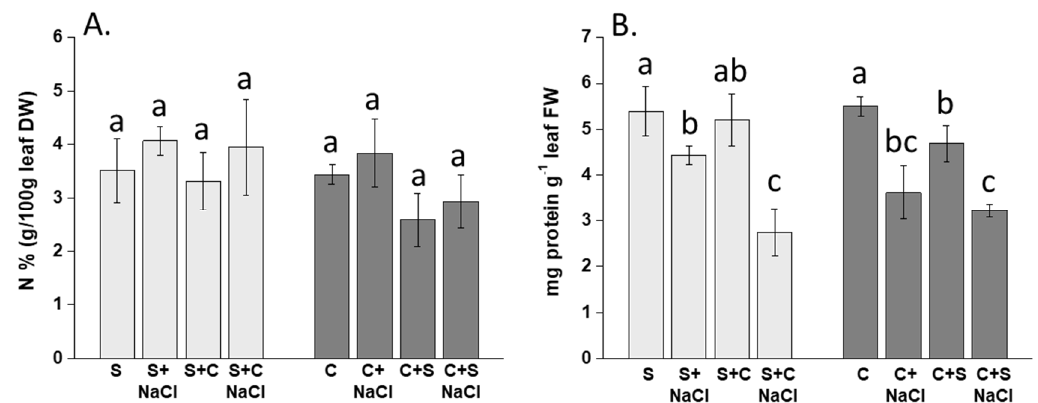
Figure 5. ( A ) Percentage of N in dried leaves of soybean and C. album , treated and nontreated with NaCl. ( B ) Protein content per gram of leaf fresh weight (FW) of soybean and C. album , treated and nontreated with NaCl. Different letters within each group of bars indicate significant differences at p < 0.05, n = 3. S = soybean; C = C. album . The experiment was replicated twice, and only data from one representative experiment are shown.